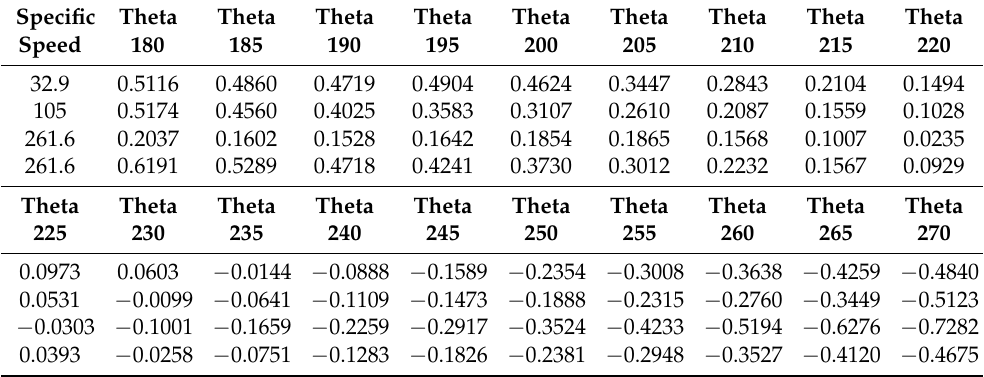
Table 3. Normalized dimensionless torque third-quadrant input datasets for test